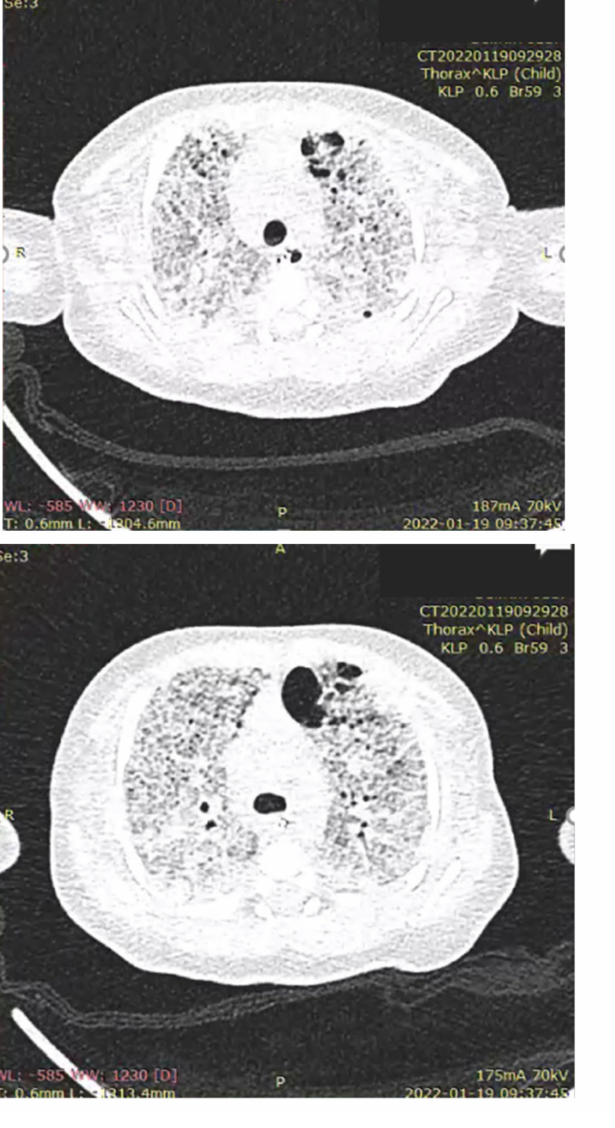
Figure 3. Computed tomography shows a characteristic pattern of interstitial lung disease with ground-glass opacities and